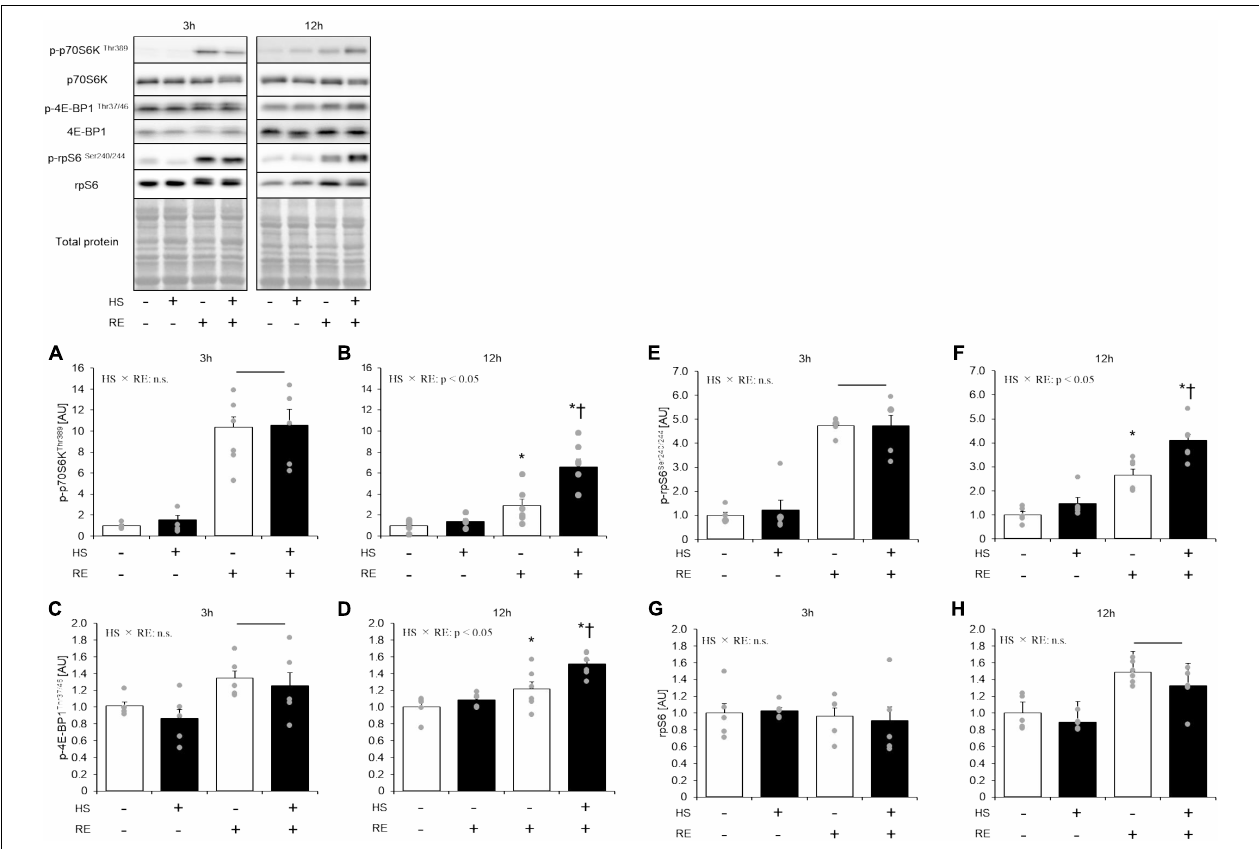
FIGURE 4 | The effect of an acute RE on mTORC1 targeting substrates after 14 days of hindlimb suspension. Changes in the phosphorylation of p70S6K Thr389 in response to acute resistance exercise after hindlimb suspension (A,B) . Change in the phosphorylation of 4E-BP1 Thr37/46 in response to acute resistance exercise after hindlimb suspension (C,D) . Changes in the phosphorylation of ribosomal protein S6 (rpS6) Ser240/244 in response to acute resistance exercise after hindlimb suspension (E,F) . Changes in the expression of ribosomal protein S6 (rpS6) in response to acute resistance exercise after hindlimb suspension (G,H) . All changes in protein expression were normalized to total protein. HS: hindlimb suspension. RE: acute resistance exercise. 3 h: 3-h after exercise. 12 h: 12-h after exercise. Values are means ± SE ( n = 5–6/group). Black line: main effect of RE ( p < 0.05). *: p < 0.05 vs. non-exercised control leg within each group. † : p < 0.05 vs. CON group within same